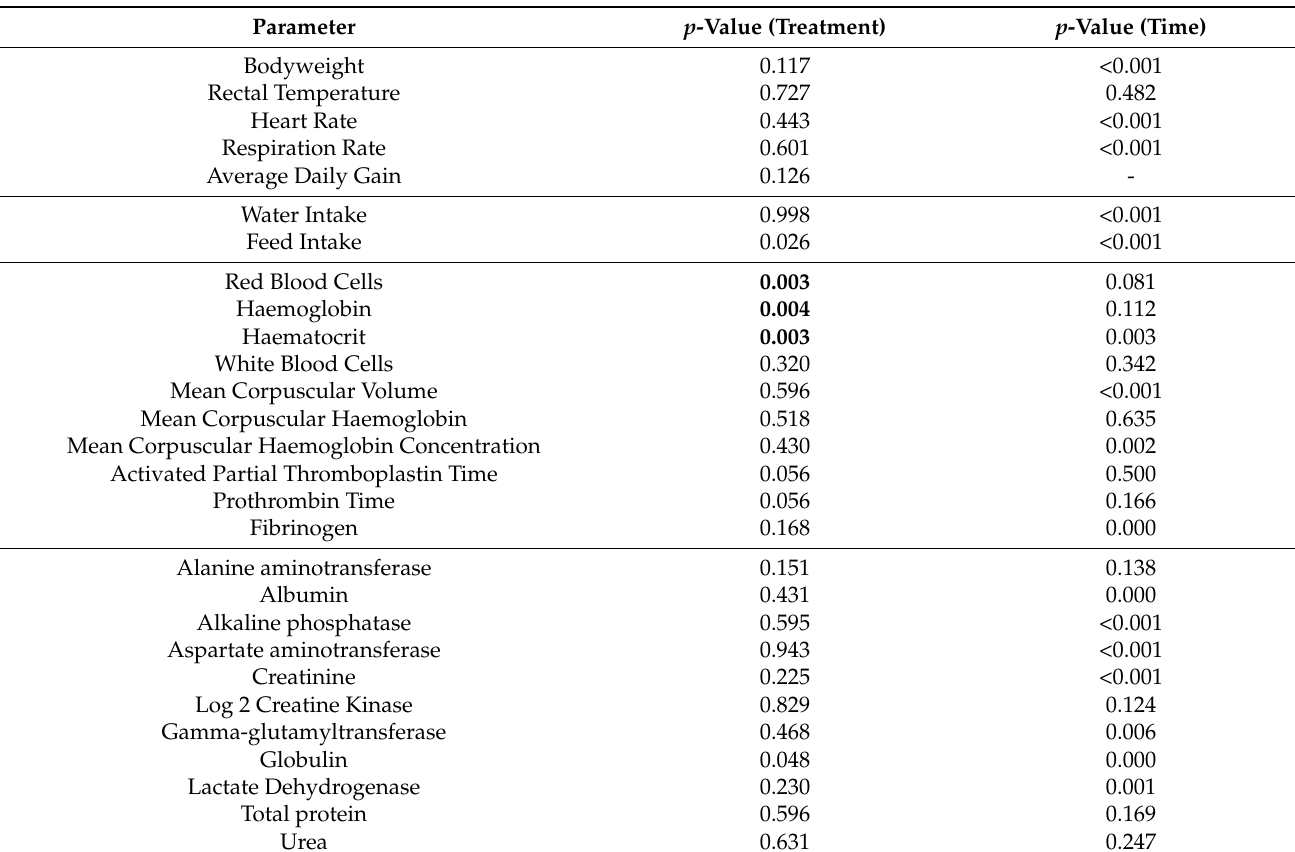
Table 2. Statistical analysis of key safety parameters and observed p -Values for treatment (and time as appropriate). Statistically significant results are indicated in